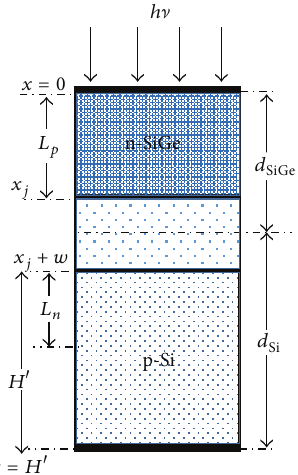
Figure 6: Layer structure of SiGe/Si solar